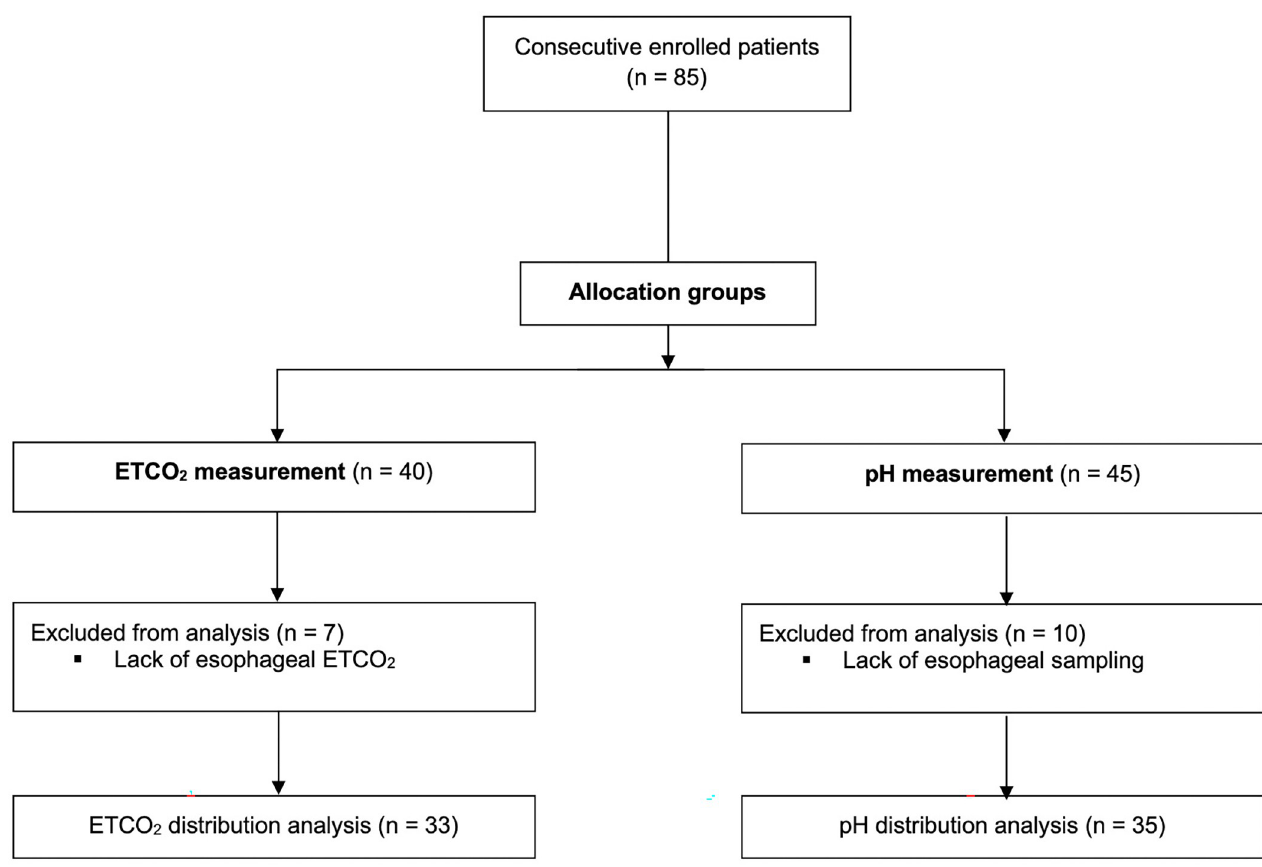
Fig 1. Patients distribution. Study patients’ allocation and distribution.